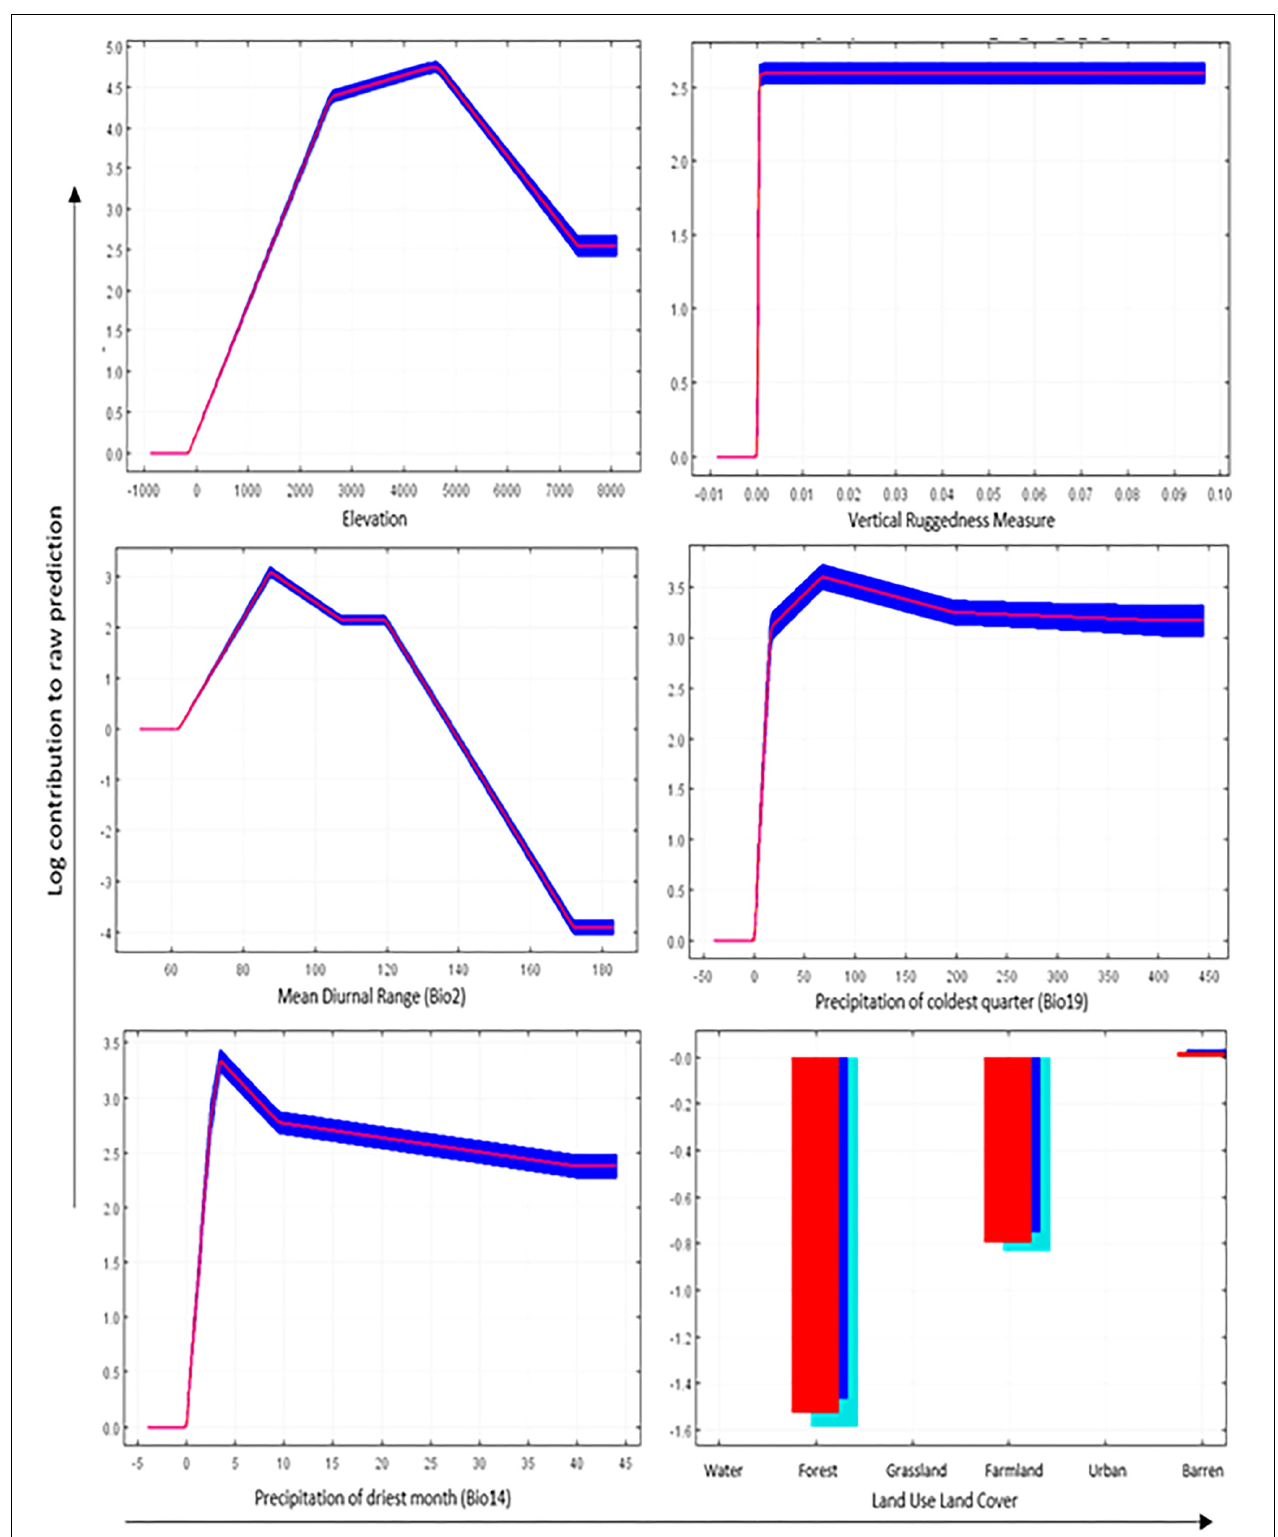
FIGURE 2 | MaxEnt model response area curves of the predictor variables influencing wooly wolf distribution: elevation; vertical ruggedness; mean diurnal range (Bio2); precipitation of coldest quarter (Bio19); precipitation of driest month (Bio 14) and land use land cover.